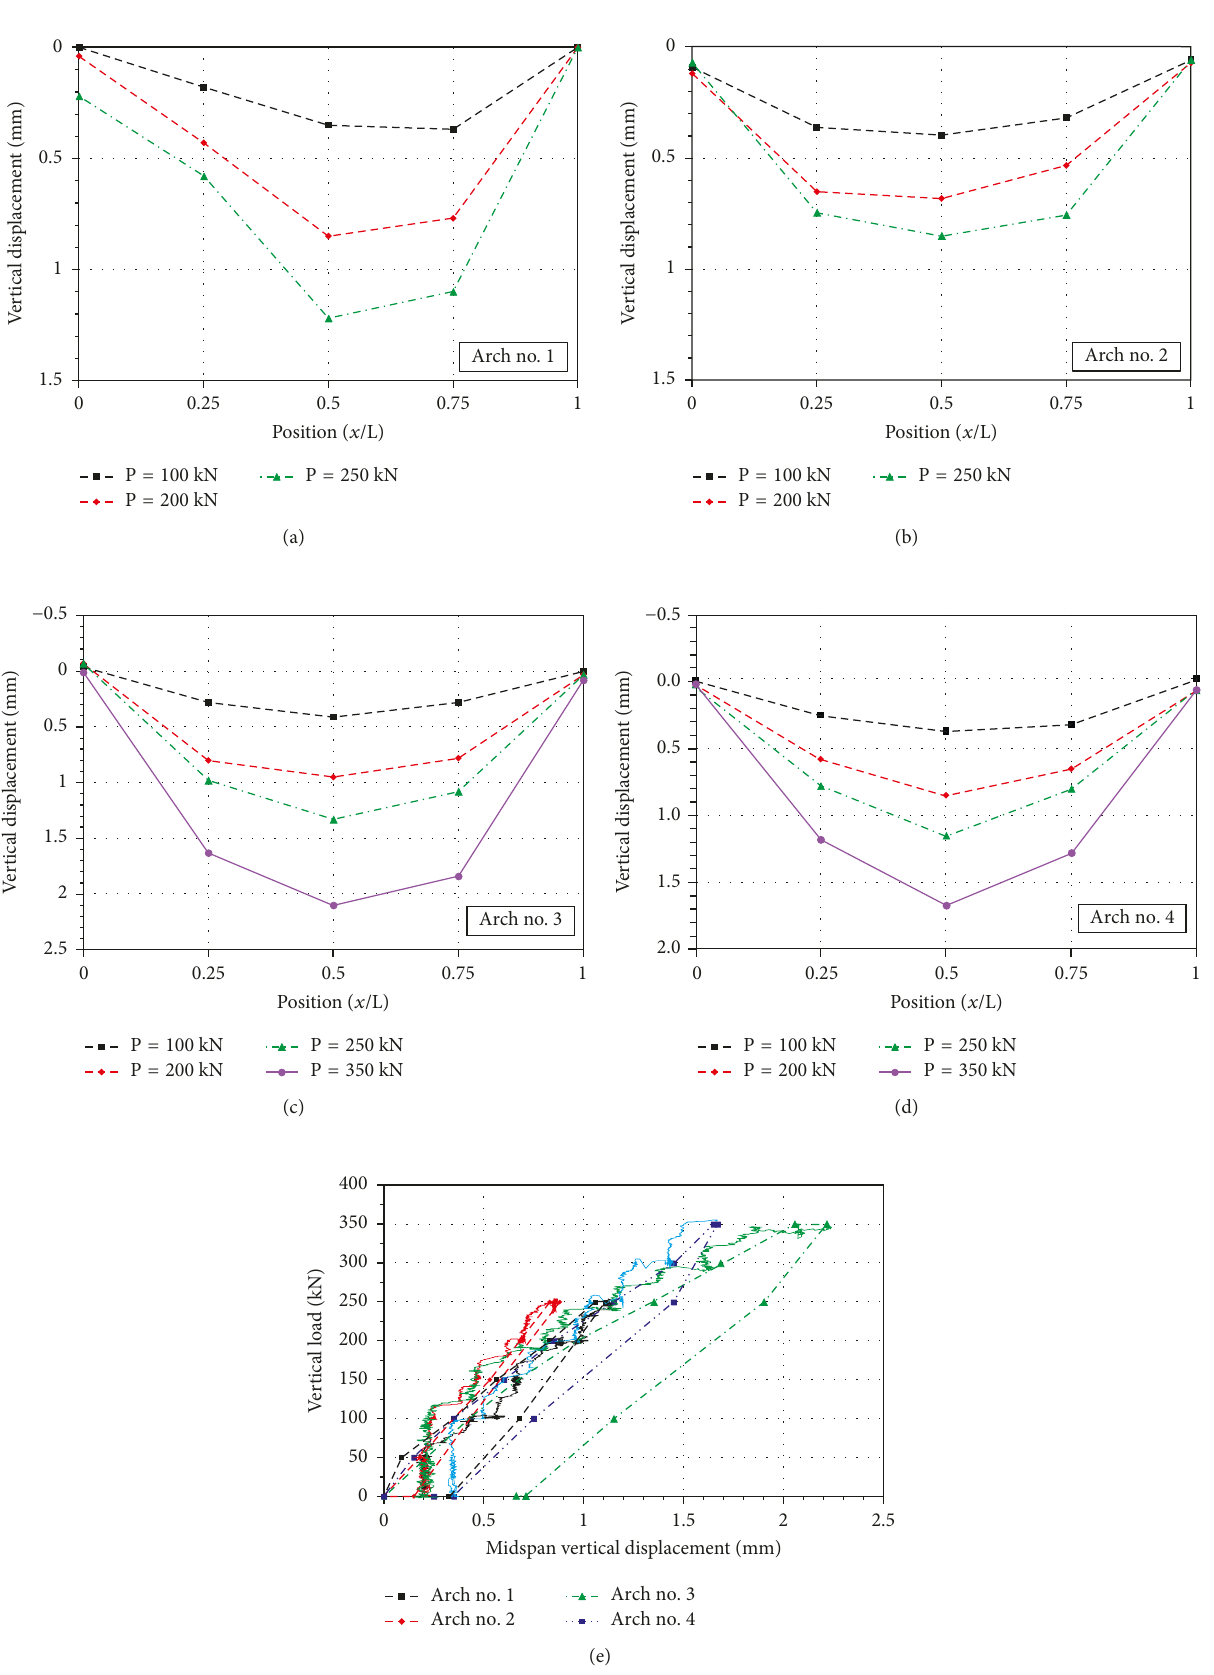
Figure 9: Test on arches subject to static symmetric loading: (a)–(d) vertical displacements obtained by optical level; (e) comparison of displacements at